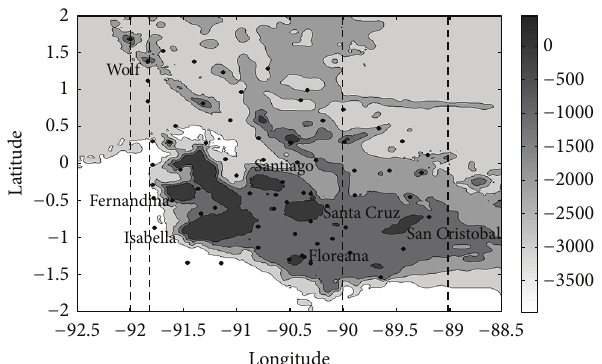
Figure 1: Bathymetry map and sampling stations (for 2005-2006 cruises) of the Gal´apagos Archipelago. The lines show the vertical sections used in Figures 15 and 17 (along the 92 ∘ W, 91.8 ∘ W, 90 ∘ W, and 89 ∘ W).